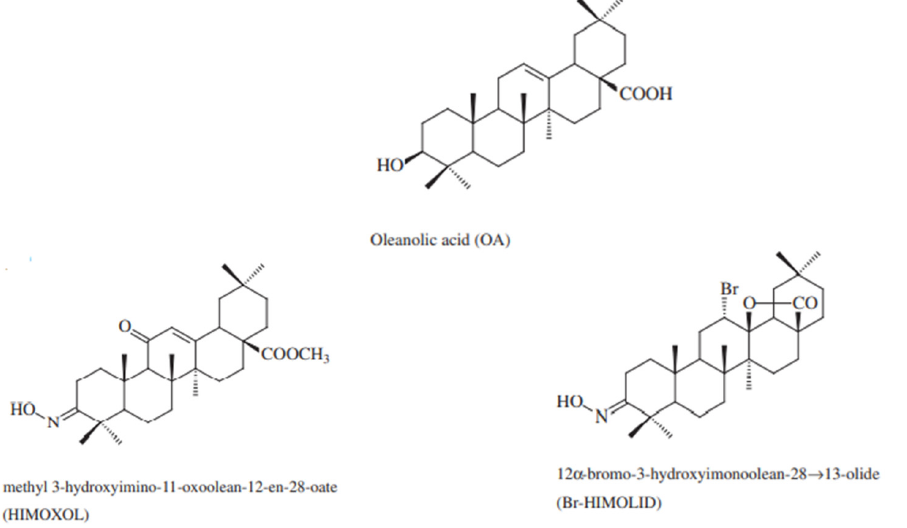
Figure 8. Structure of studied compounds.